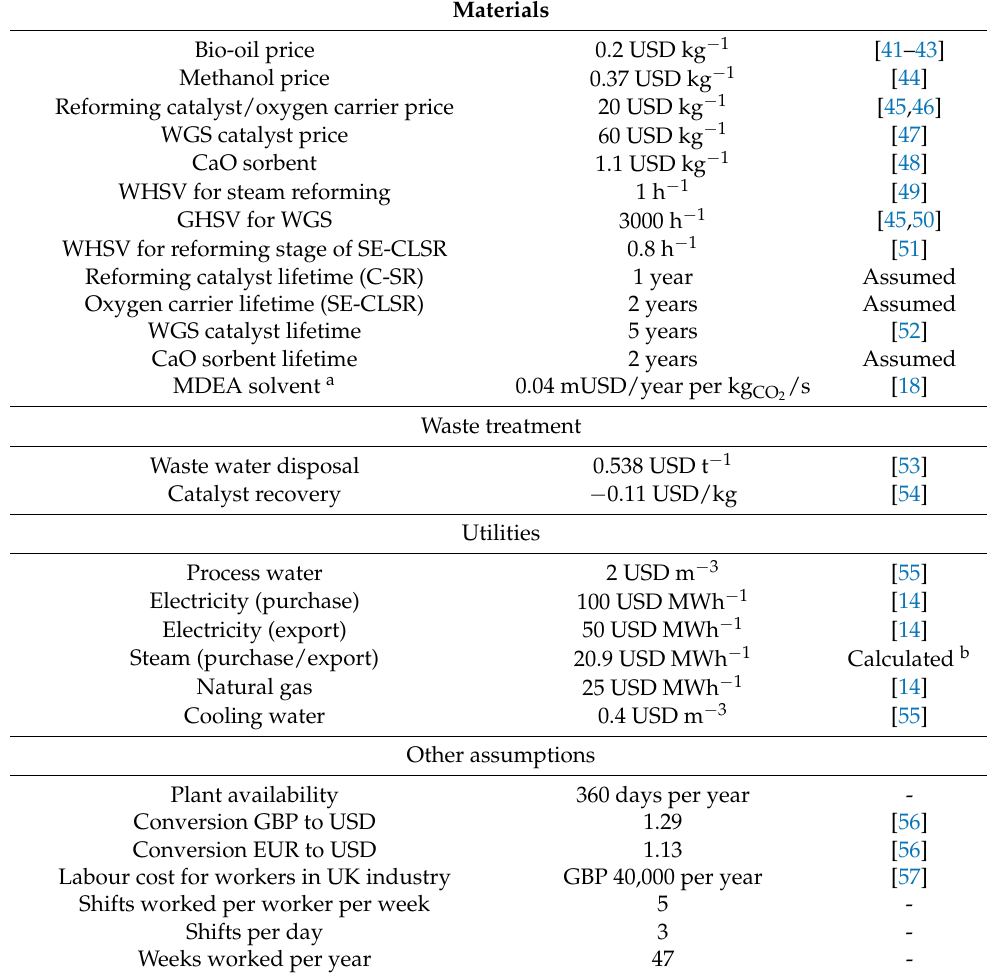
Table 4. Operating cost calculation